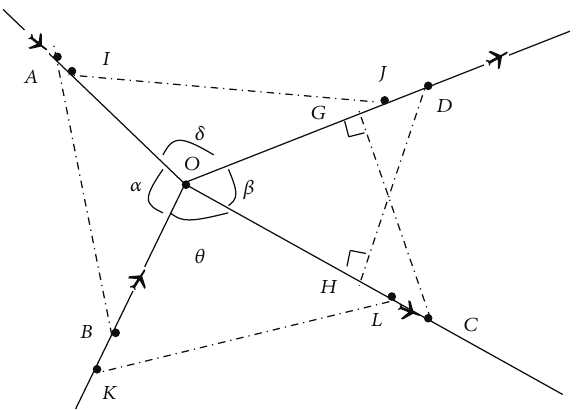
Figure 5: Type II horizontal crossing protection zone.